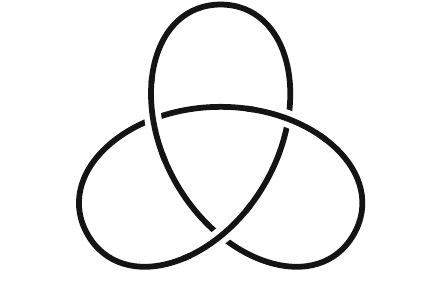
Fig. 1 The trefoil knot 3